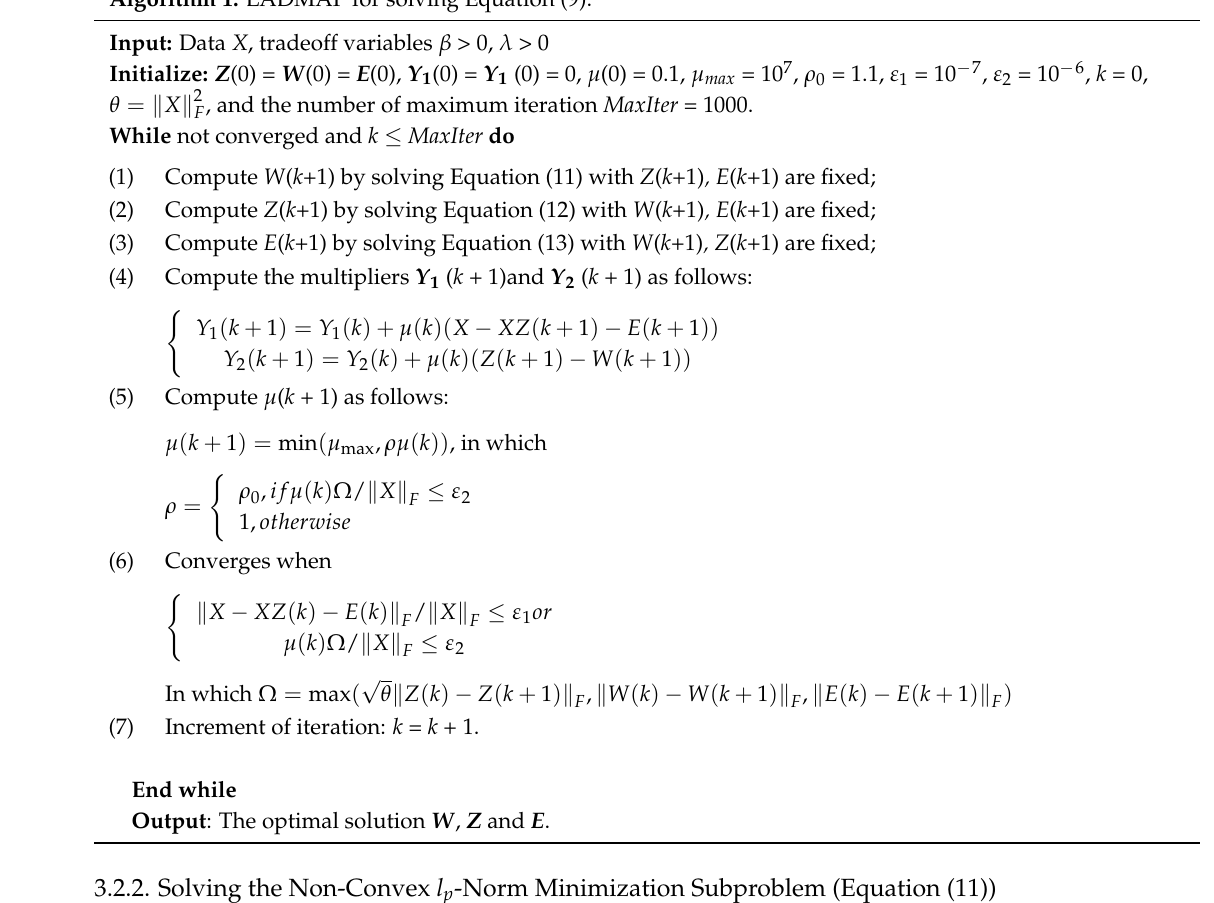
Algorithm 1. LADMAP for solving Equation